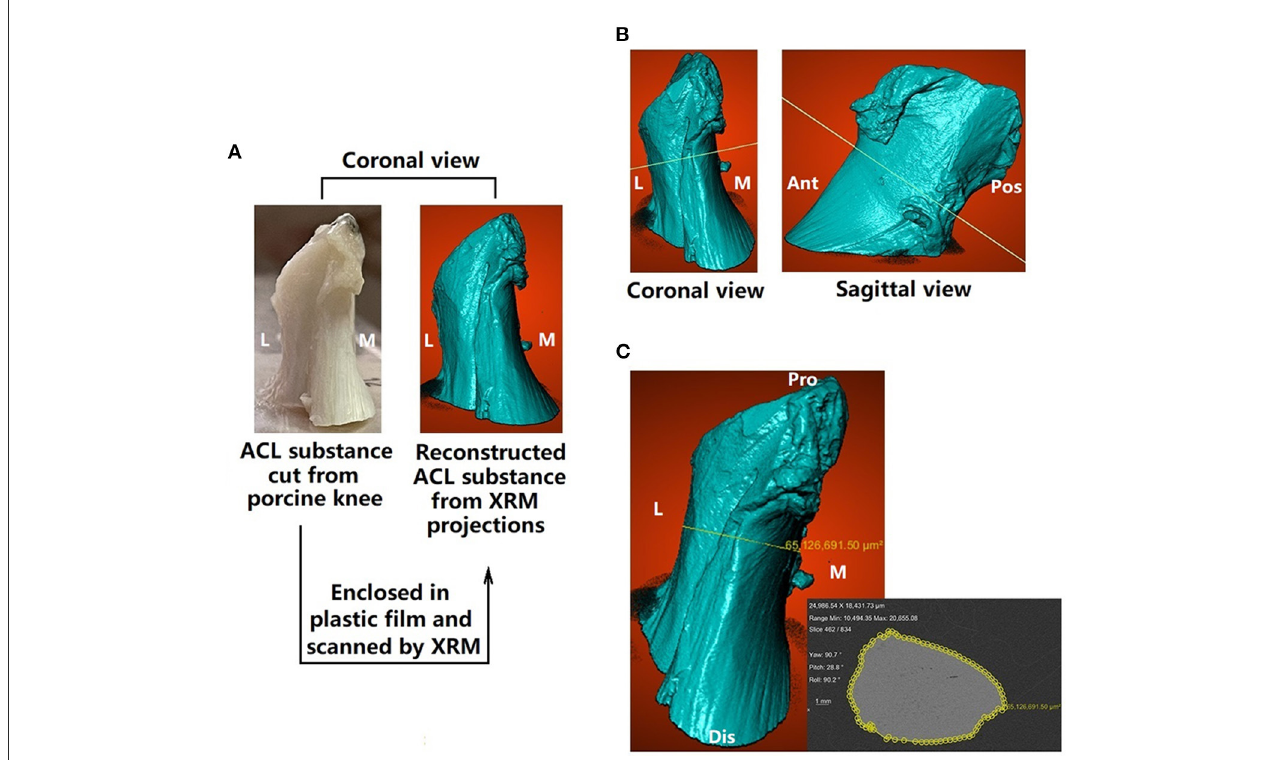
FIGURE3 Measuring cross-sectional area (CSA) of the ACL. (A) ACL substance was cut from the porcine knee, enclosed in plastic film and scanned by x-ray microscopy (XRM) (B) a plane (isthmus plane) was found to simultaneously go through the ACL isthmus in the coronal and sagittal views (C) CSA at ACL isthmus (enclosed by yellow rings) was measured on the isthmus plane. M, medial; L, lateral; Ant, anterior; Pos, posterior; Pro, proximal; Dis,